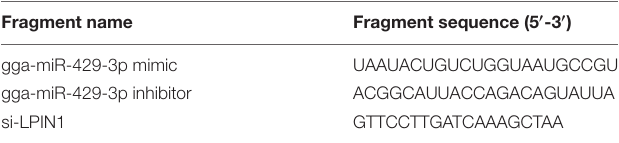
TABLE 2 | Oligonucleotides sequence